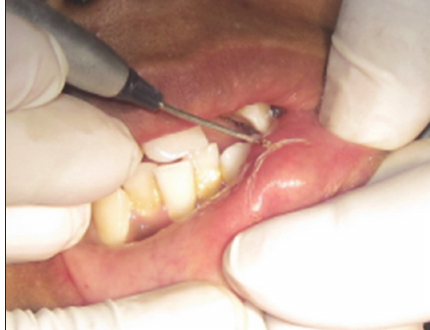
Figure 2: Application of laser: parameters, 940nm and 1.5 W; continuous mode, 400 microns.